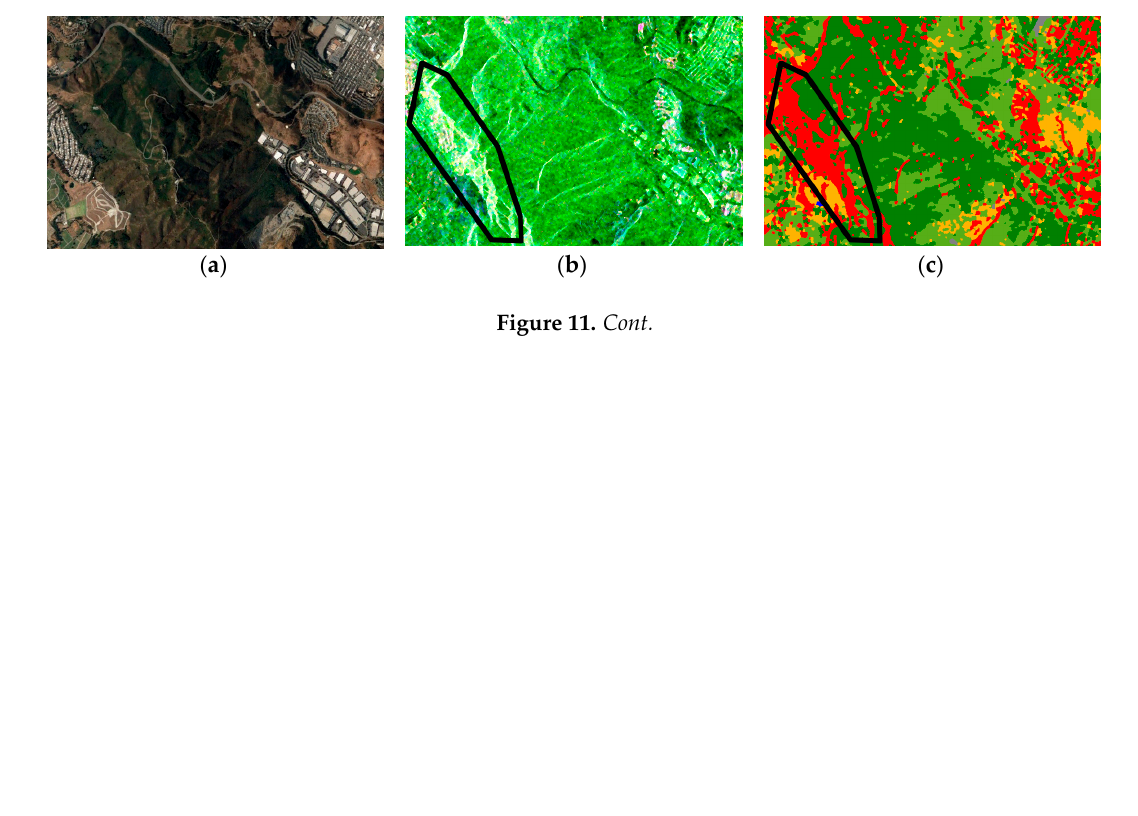
Figure 10. ( a ) Part of RF classification result; ( b ) corresponding area after majority vote; ( c ) whole classification result after majority vote; ( d ) updated result for the “Bare soil with little vegetation” class, divided into Bare soil and Herbaceous vegetation classes; and ( e ) the colormap for each category.